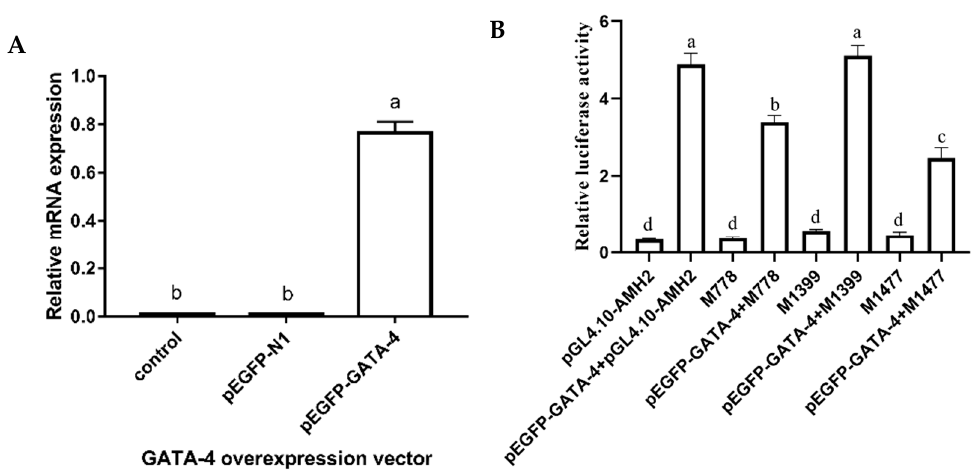
Figure 6. The effect of GATA-4 binding sites on the transcription regulation of AMH gene in geese. ( A ) Overexpression of GATA-4 in the CHO cells. pEGFP-N1 represented an internal control. pEGFP-GATA-4 represented the overexpression plasmid of GATA-4 gene. ( B ) Three binding sites of GATA-4 in the promoter region of goose AMH and mutation constructions were transfected into CHO cells. pGL4.10–AMH2 represented the wild binding sites of GATA-4 in the promoter region of goose AMH . M778, M1399 and M1477 represented the mutation binding sites of GATA-4 in the promoter region of goose AMH , respectively. pEGFP-GATA-4 + pGL4.10-AMH2, pEGFP-GATA-4 + M778, pEGFP-GATA-4 + M1399 and pEGFP-GATA-4 + M1477 represented the co-expression transfection of pEGFP-GATA-4 and three mutation binding sites in the CHO cells, respectively. Each column represented the mean ± SD ( n = 3). Different lowercase letters represented the evident difference ( p < 0.05).